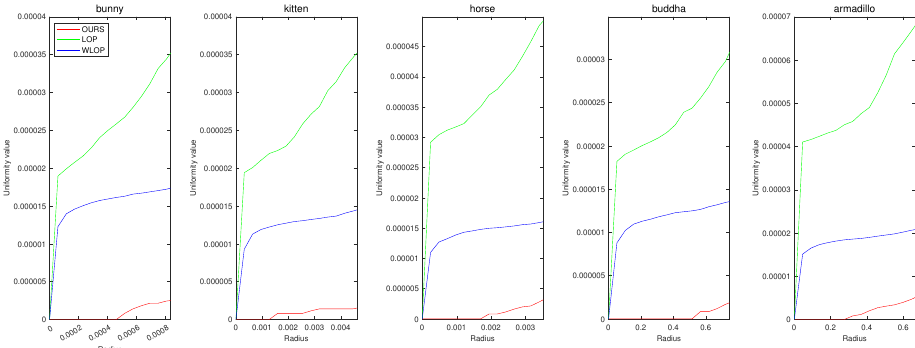
Figure 7. Quantitative results for the omnidirectional noise cases. Each column represents different input data (first column: Horse; second column: Bunny; third column: Kitten; fourth column: Buddha; and fifth column: Armadillo).